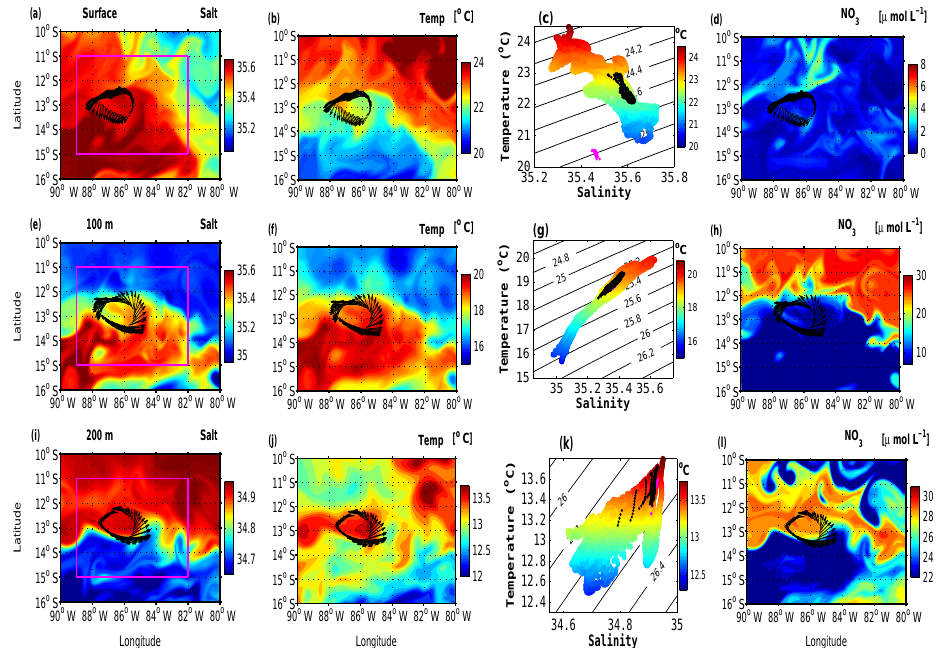
Figure 13. Water mass properties and nitrate distribution around the eddy B sim . Left panels: spatial distribution of simulated salinity at sur- face (top), 100m (middle) and 200m depth (bottom). Middle-left panels: the same as left panel, but for temperature. Middle-right panels: TS relation for surface (top), 100m (middle) and 200m depth (bottom) waters. Right panels: the same as left panel, but for nitrate. The arrows represent the circulation patterns at the eddy’s edge. Black and magenta dots in the TS diagram correspond to the water masses within the eddy at the instant after the eddy formation (magenta) and the instant shown in Fig. 4 (black dots). The magenta box in Fig. 11a indicates the region over which the TS diagram is